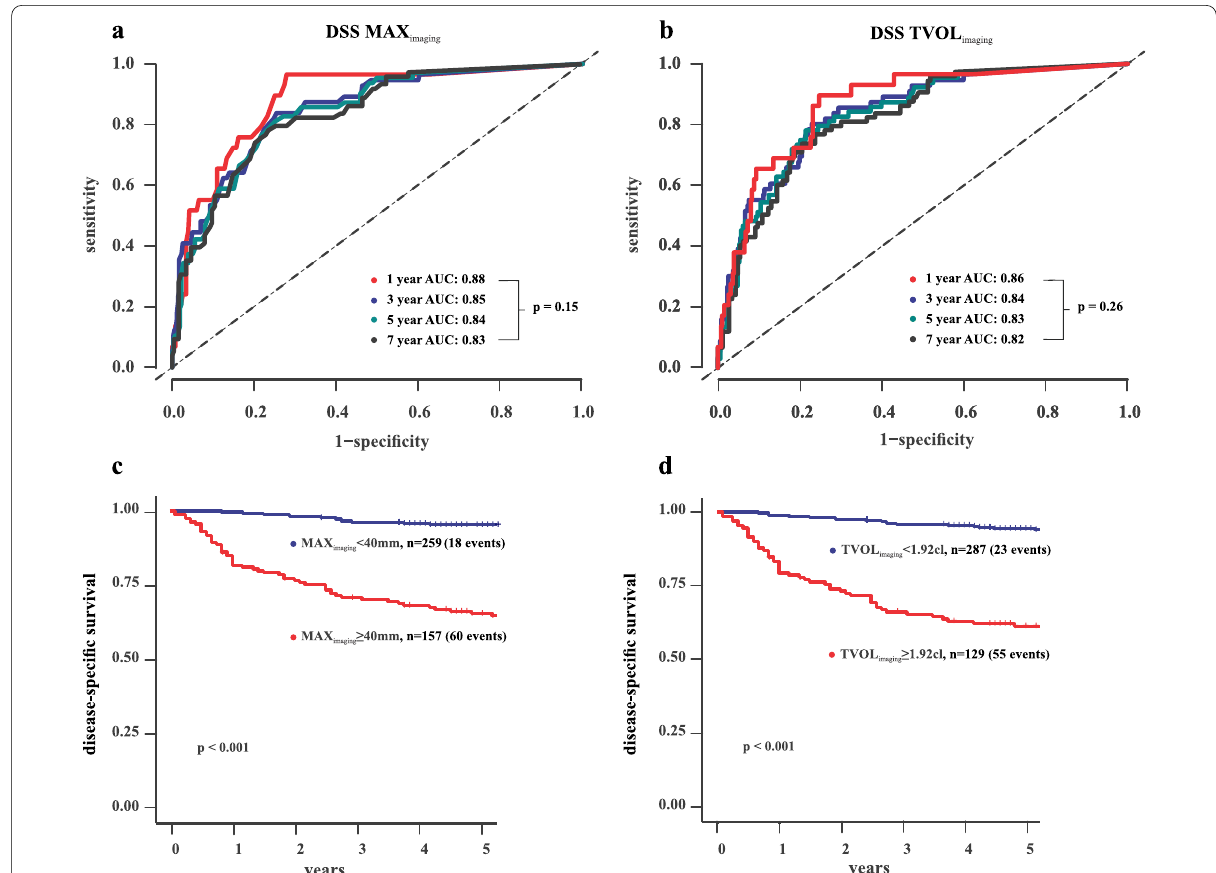
Fig. 4 Time‑dependent receiver operating characteristics curves (tdROC) at 1, 3, 5, and 7 years after primary diagnosis for predicting disease‑specific survival (DSS) based on MRI‑measured maximum tumor diameter (MAX imaging ) ( a ) and tumor volume (TVOL imaging ) ( b ); both showed non‑significant reduction in AUC over time. Kaplan–Meier curves depict significantly reduced disease‑specific survival in patients with MAX imaging 4.0 cm ( p < 0.001) ( c ) and TVOL 1.92 cl ( p < 0.001) ( d ). For each category: number of patients/number of patients dying from the ≥ ≥